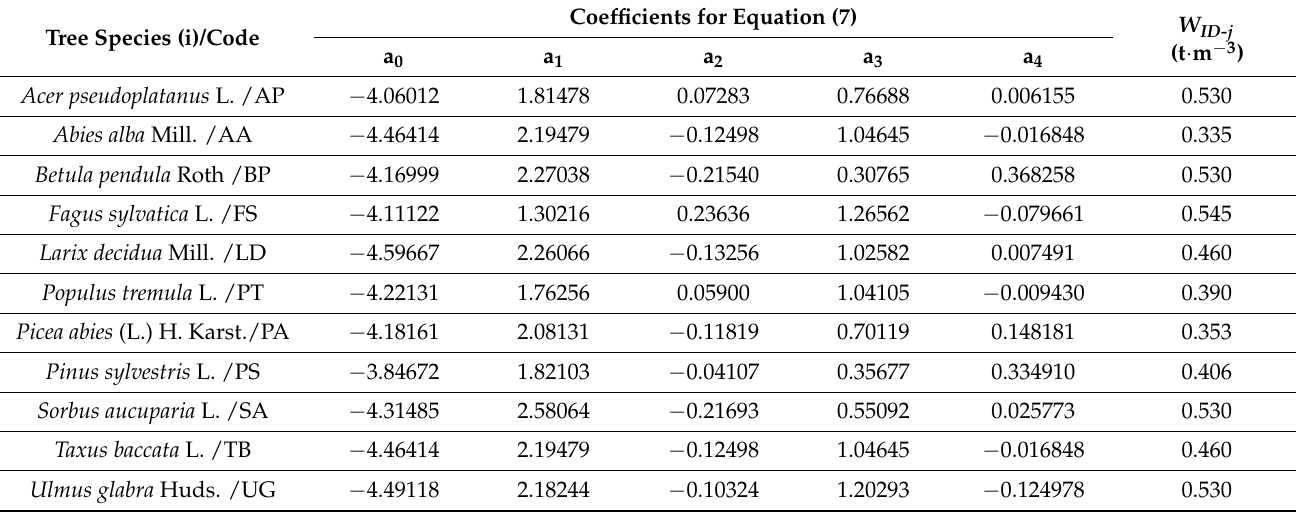
Table 1. Coefficients used for computing the tree aboveground wood volume (according to [77]) and aboveground biomass (according to [78]). W ID is the mean value of wood infra-density. Tree Species